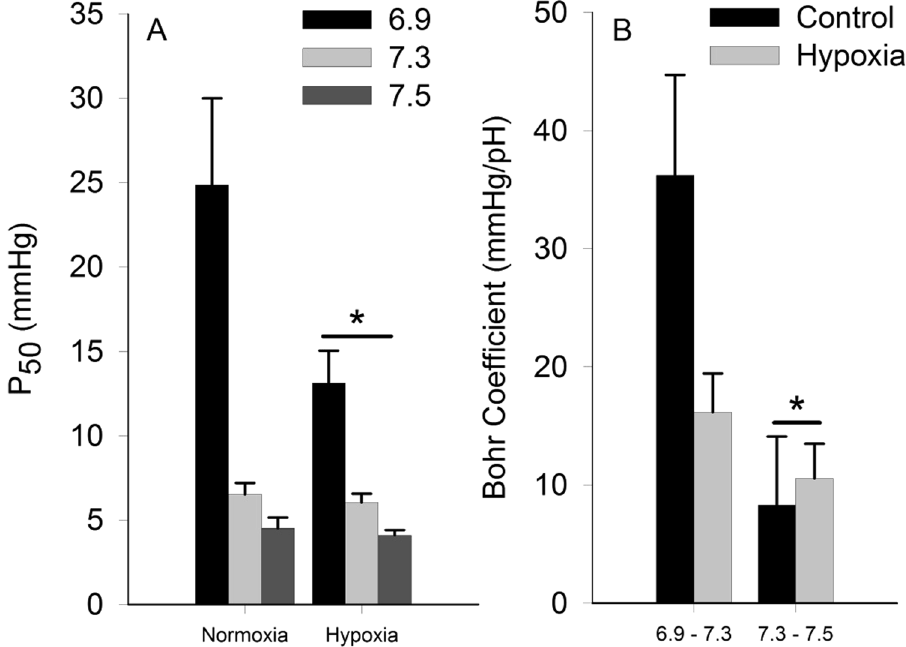
Figure 4. Non-stripped hemolysate P 50 ( A ) and Bohr coefficients ( B ) for fish acclimated for 21 days to normoxia and hypoxia. A significant difference between treatments is denoted by an asterisk (two-way ANOVA; P < 0.05; N = 4–7). Note that a significant interaction between oxygen level and pH was not observed for either